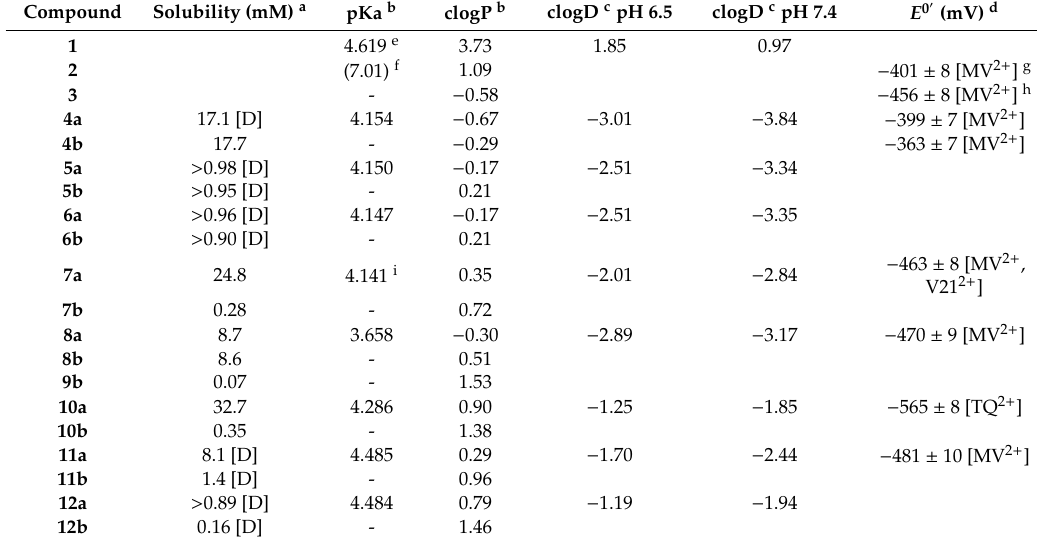
Table 1. Solubility, pKa, lipophilicity, and one-electron reduction potentials of BTO acids and comparator